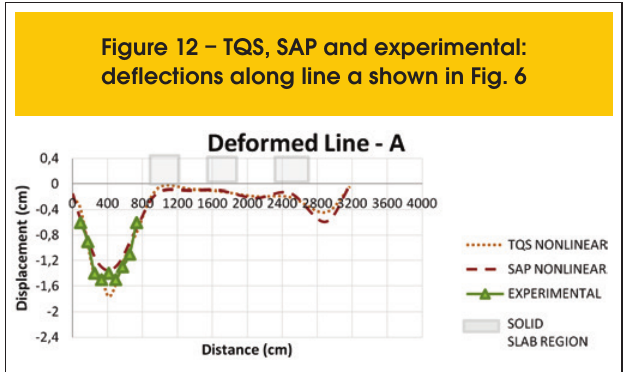
Figure 13 – TQS, SAP and experimental: deflections along line B shown in Fig. 6